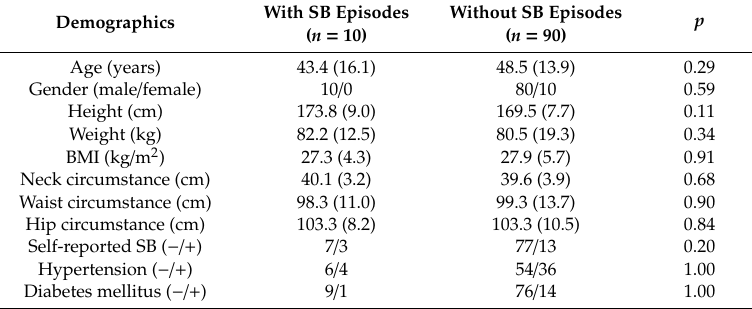
Table 1. Clinical characteristics in patients with obstructive sleep apnea syndrome (OSAS) with and without sleep bruxism (SB) episodes. With SB Episodes Without SB Episodes p Demographics ( n =